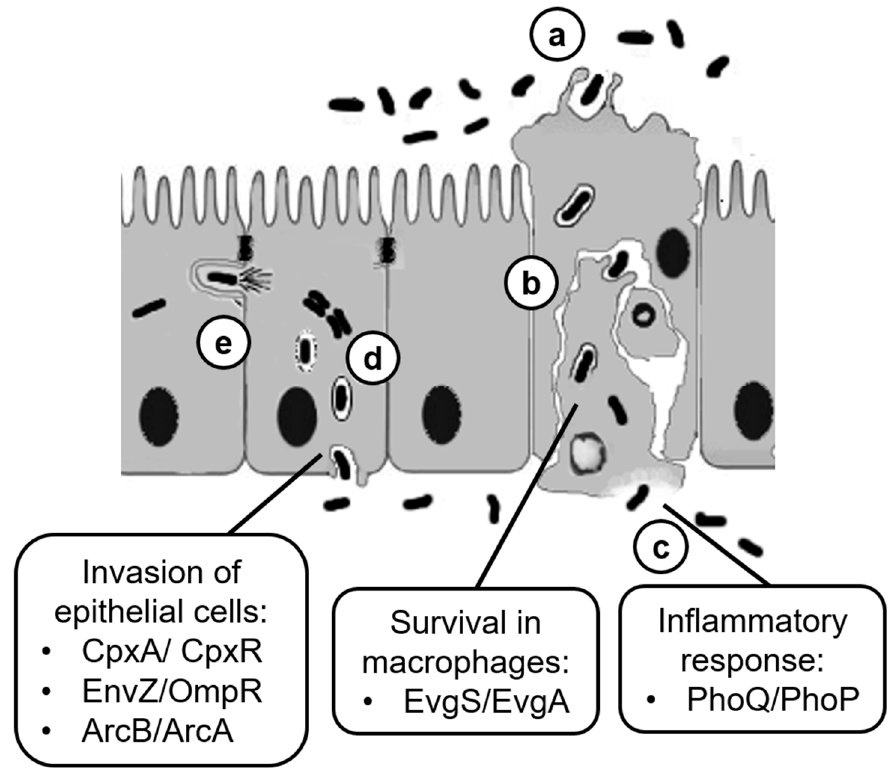
Figure 2. Role of TCS systems in the different steps of the invasive process of Shigella. (a) Shigella crosses the colonic epithelium via M cell translocation. (b) Shigella invades the resident macrophages, induces lysis of the phagolysosome, surviving the cell attack, and (c) escapes the macrophages by triggering inflammatory cell death (pyroptosis) with a consequent release of proinflammatory cytokines. (d) Shigella invades epithelial cells of colonic mucosa by stimulating macropinocytosis, induces vacuole lysis, multiplies in the cell cytosol, and (e) spreads to adjacent cells using actin-based motility. The involvement of TCS systems in the various steps is reported in the